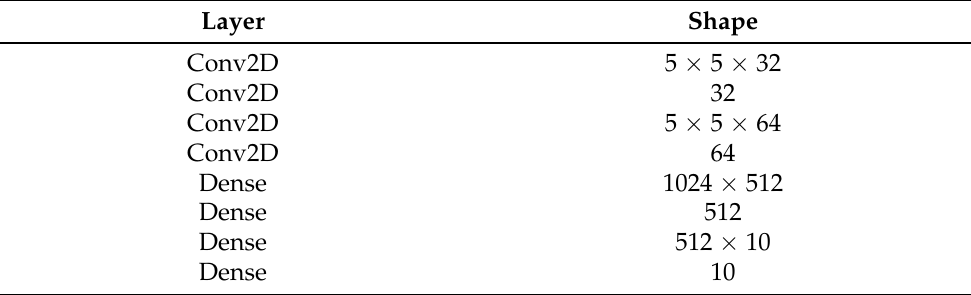
Table 1. Parameters settings for the CNN.